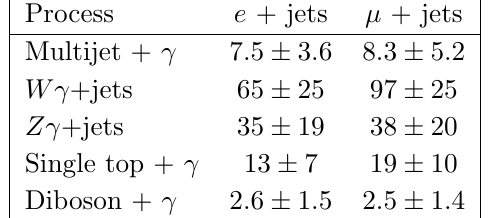
Table 1. Expected yields of background processes with a prompt photon. The uncertainties include all sources of systematic uncertainty described in section